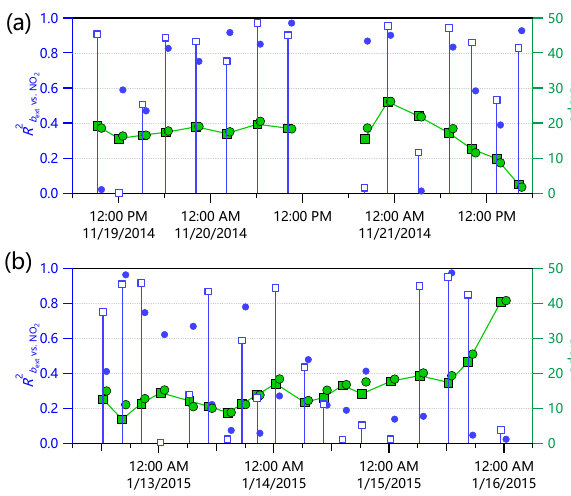
Figure 10. Time series of correlation coefficients ( R 2 ) and slopes between b ext and NO 2 for each vertical profile in (a) November and (b) January. The circles refer to the down profiles while other are the up